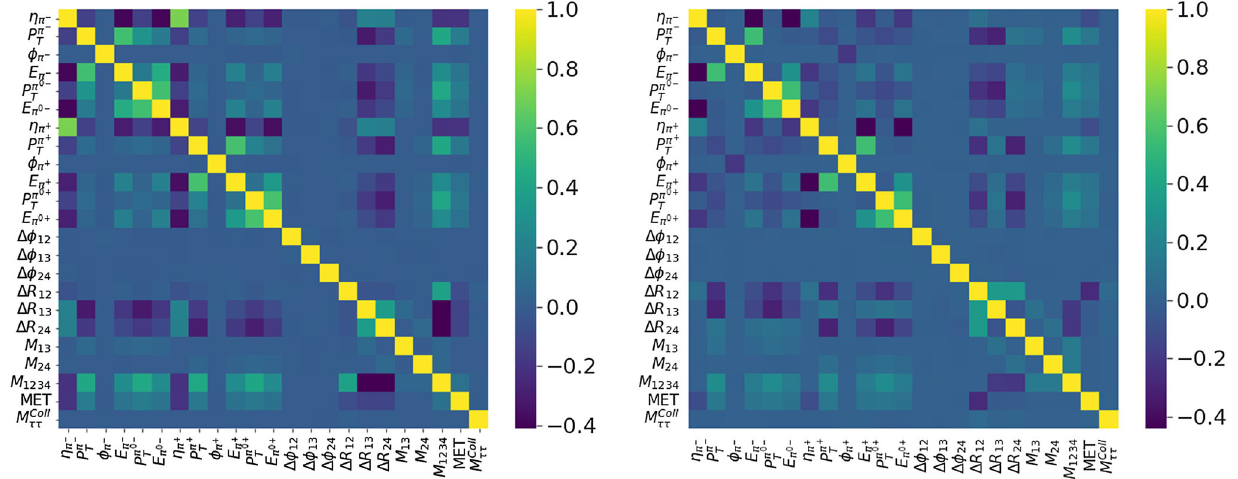
Fig. 9 Correlation among the kinematic observables (both low level as well as high level), which are used as input to the deep learning algorithm is displayed here. The left and right panel corresponds to the background and signal events, respectively